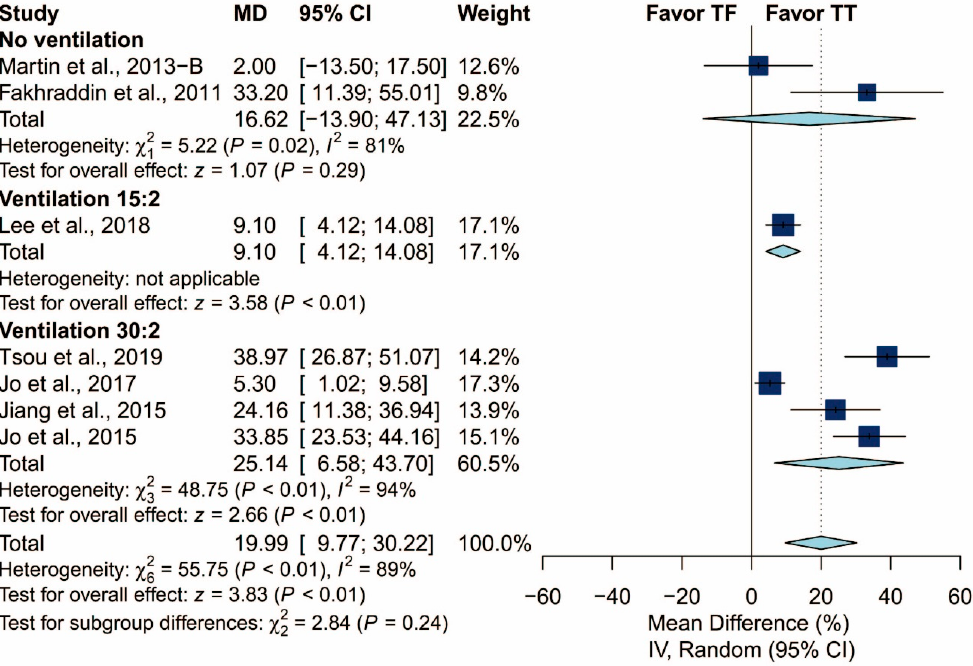
Figure 13. Subgroup analysis of the proportion of adequate compression depth grouped by ventilation protocol (15:2/30:2/no). protocol (15:2 / 30:2 /